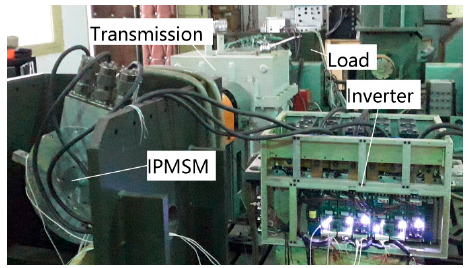
Figure 7. Experimental setup.